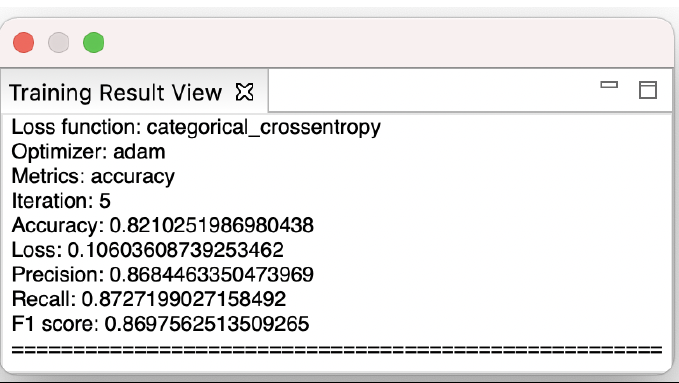
Figure 6. The tool screenshot of Training Result View